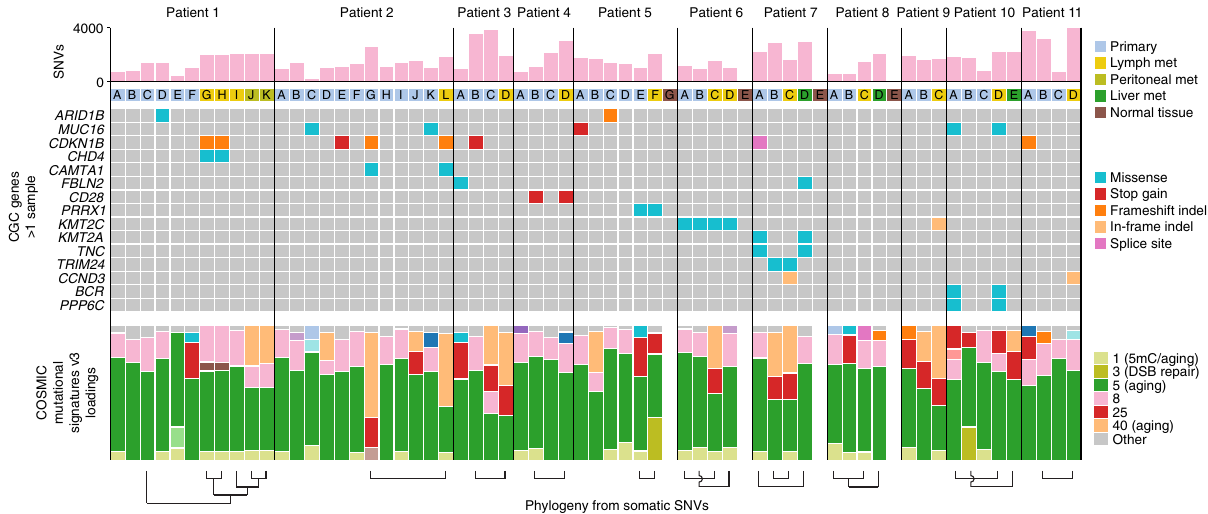
Fig. 3 Overview of potential driver mutations and mutational signatures for all 11 patients. All Cancer Gene Census (CGC) genes with non-synonymous mutations in more than one sample are shown. Mutational signature loadings, i.e., relative contributions, refer to COSMIC v3 de fi nitions 16 and were dominated by the closely related signatures SBS5 and SBS40 (see “ Supplementary Fig. 16 ” for a full signature legend). Phylogenetic relationships previously inferred from somatic SNVs (Figs. 1, 2) are indicated at the bottom. Somatic SNV burdens, potential driver mutations and mutational signature loadings in this fi gure were determined using less rigorous population variant fi ltering compared to the phylogenetic analyses (see “ Methods ” ). CGC Cancer Gene Census, met metastasis, SNV single nucleotide variant, 5mC 5-methylcytosine, DSB double strand break. Source data are provided as a Source data fi